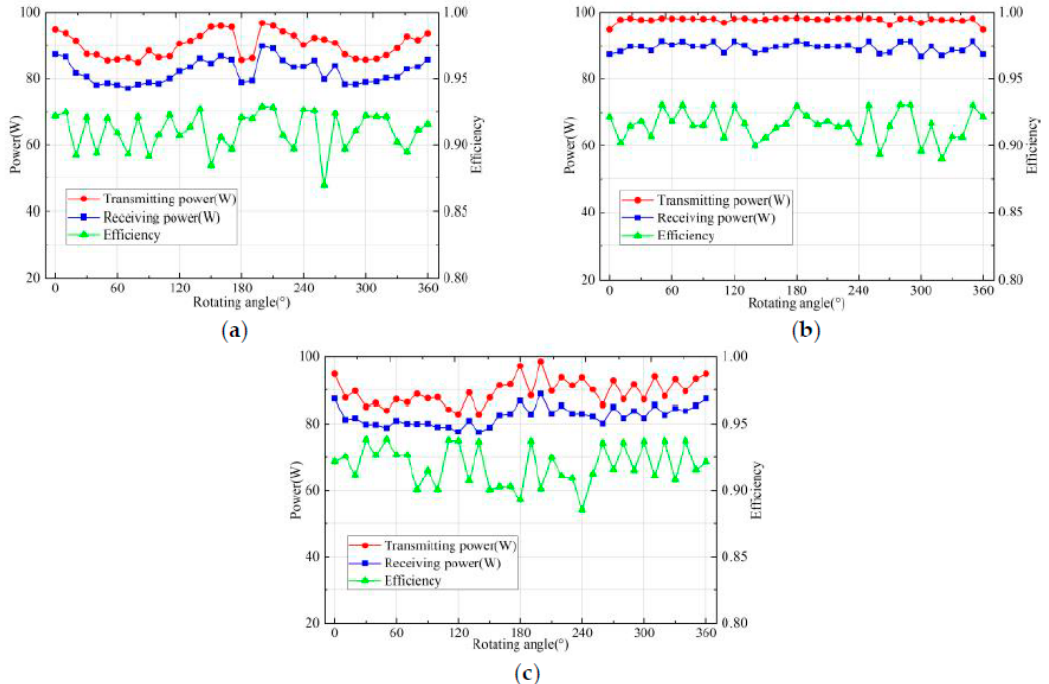
Figure 5. Simulation results of the single-wire power transfer system with rotating receivers when the ( a ) rotating axis is the x -axis, ( b ) rotating axis is the y -axis and ( c ) rotating axis is the z -axis.